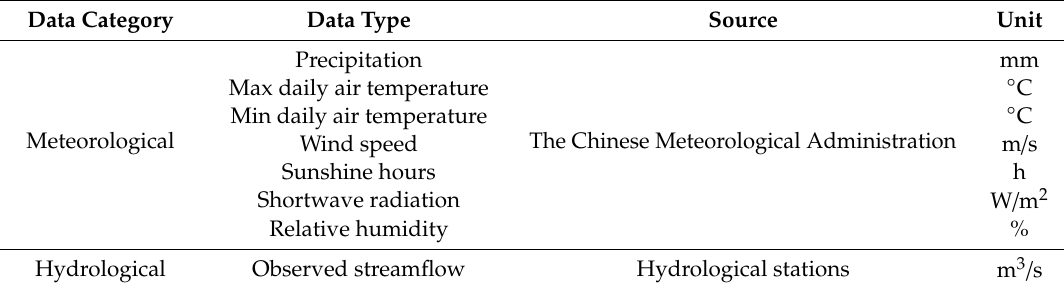
Table 1. Meteorological and hydrological data used in this